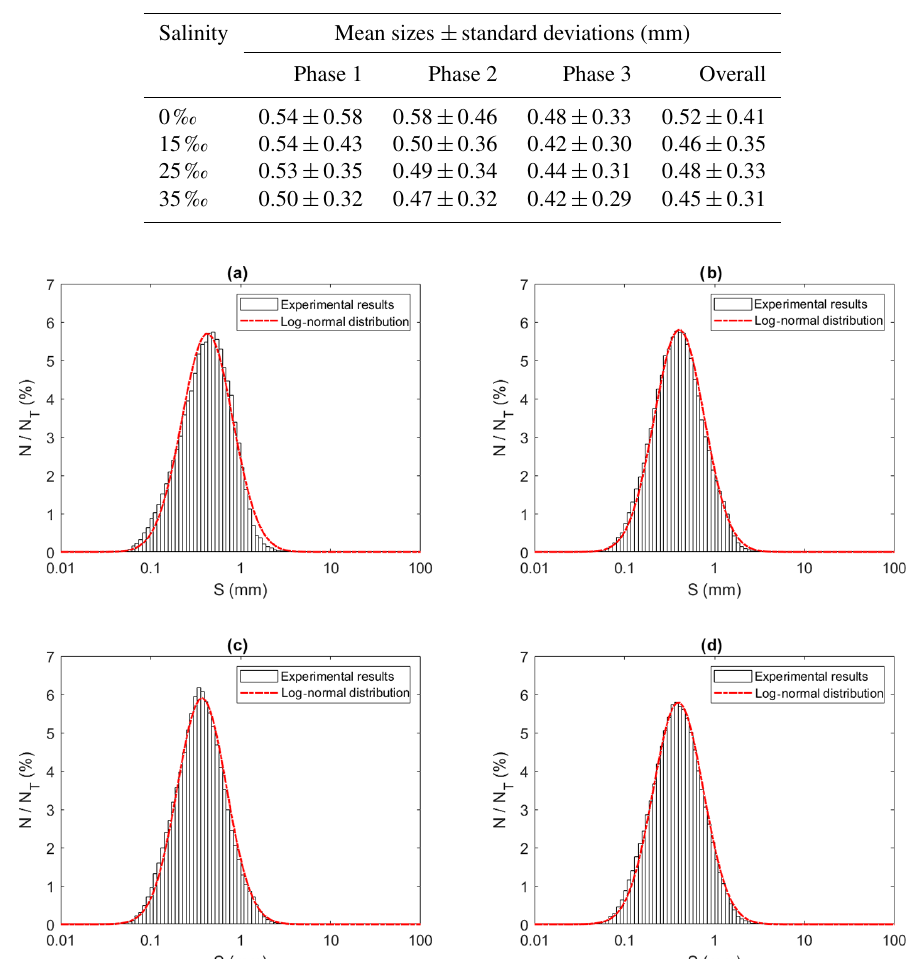
Figure 13. Size distributions of individual particles at a salinity of 35‰ during (a) Phase 1, (b) Phase 2, (c) Phase 3 and (d) the entire time interval (i.e. averaged over all three phases). N is the number of particles in each bin, N T is the total number of particles ( N T ≈ 13620, 22430, 105560 and 141610 in a , b , c and d , respectively), and S is the particle size (mm). Note that the arithmetic mean of particles sizes were 0.50, 0.47, 0.42 and 0.45mm for (a) , (b) , (c) and (d) ,